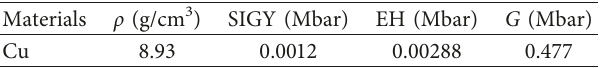
Table 3: Mechanical properties of material model 10